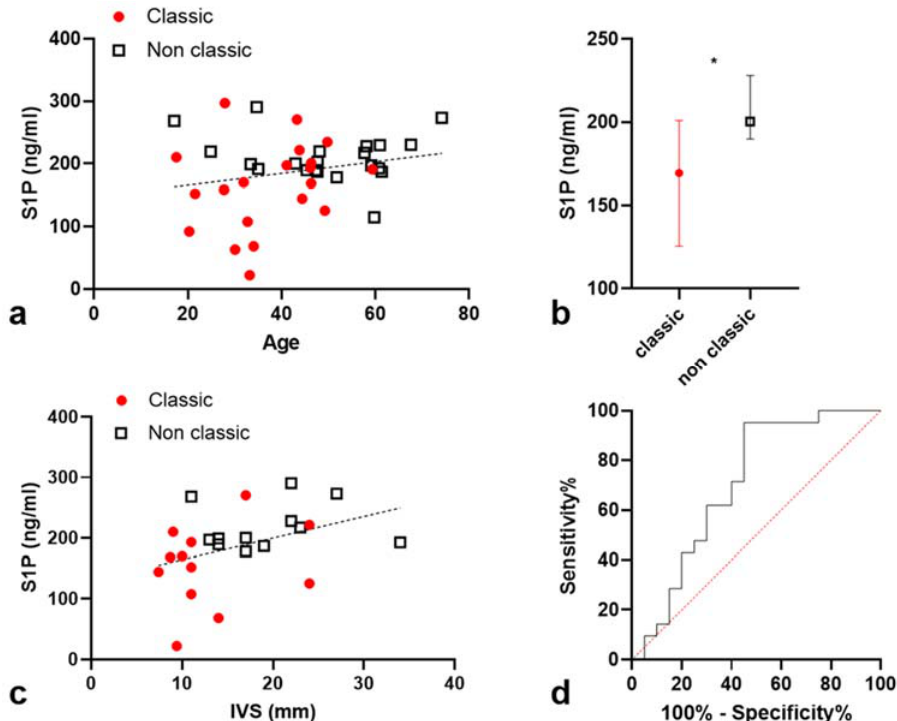
Figure 1. ( a ). Sphingosine -1-Phosphate (S1P) serum levels as a function of age; linear regression. Spearman correlation; p value not significant. ( b ). S1P levels in classic and non-classic Fabry males ( p = 0.024). ( c ). S1P serum levels as a function of interventricular thickness (r = 0.46; p = 0.02). ( d ). S1P levels and phenotype. ROC curve area 0.70 ± 0.08 ( p = 0.02). * p < 0.001.